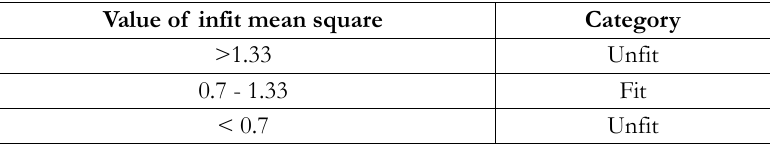
Table 3. Criteria of Sbi